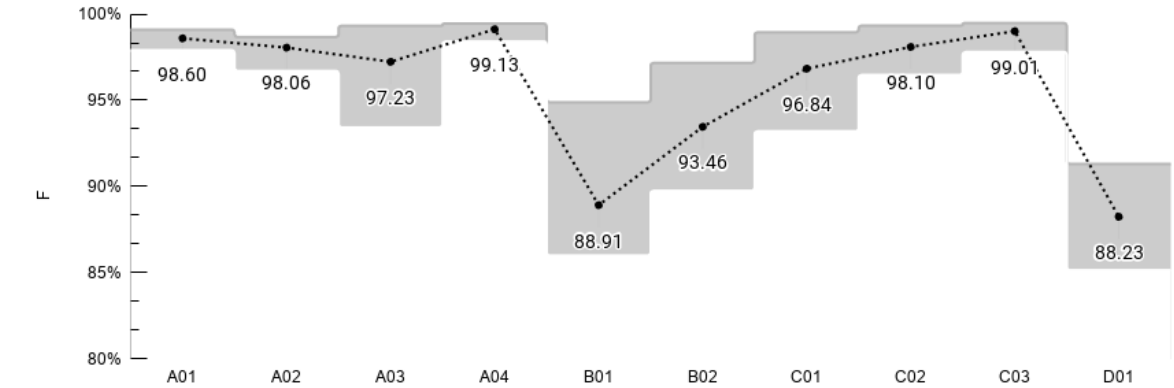
Figure 9. Graph comparing average (black dotted line) and min-max boundaries of each experiment (grey bars). Most relevant are: A03 due to low count of echoes, the improvement from B to C tests and the indetermination of D01.